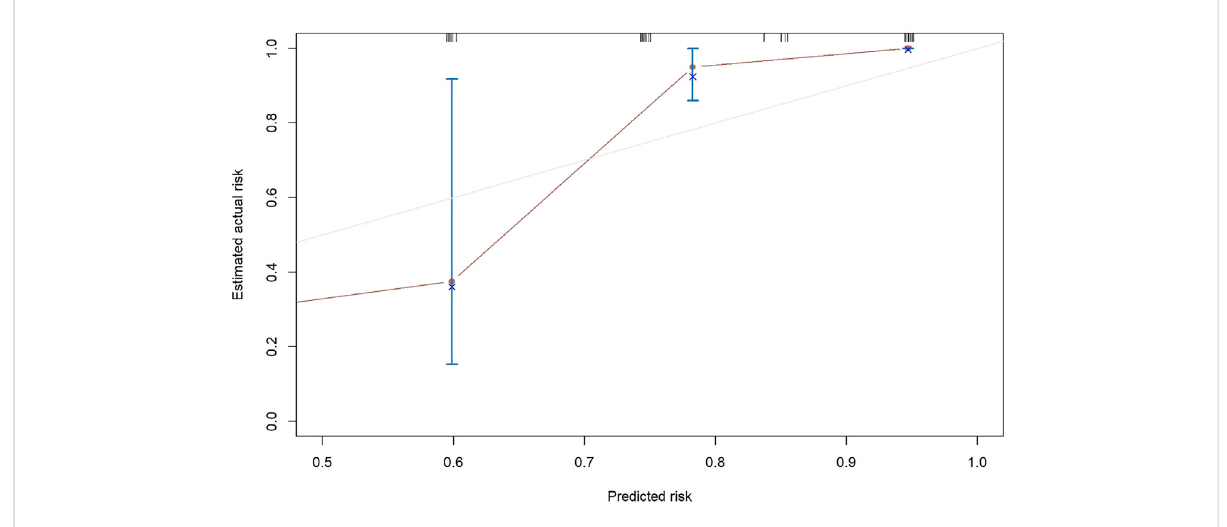
FIGURE 5 Calibration plots for 6-months progression-free survival.